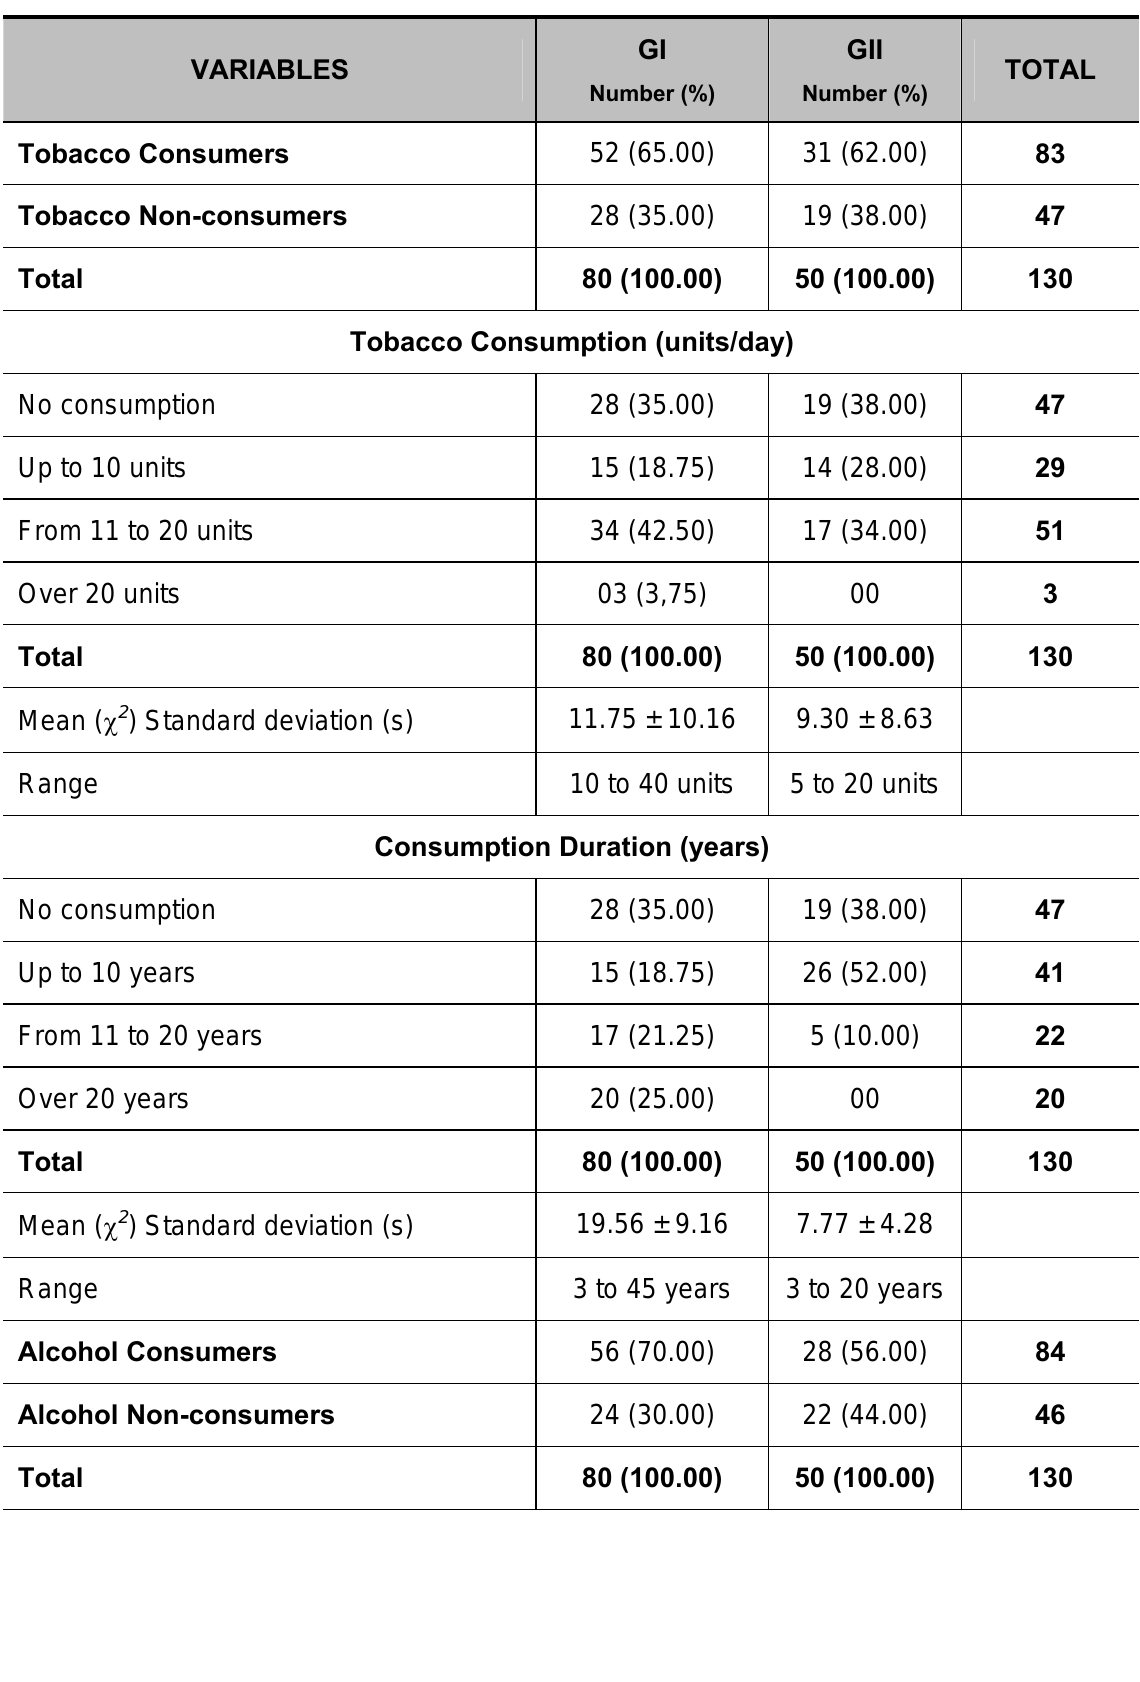
Table 2. Distribution of quantitative variables of the eighty individuals infected by C virus (GI) and fifty non-infected ones (GII), according to the amount and duration of tobacco and alcohol consumption. Mean ( χ 2 ) and standard deviation